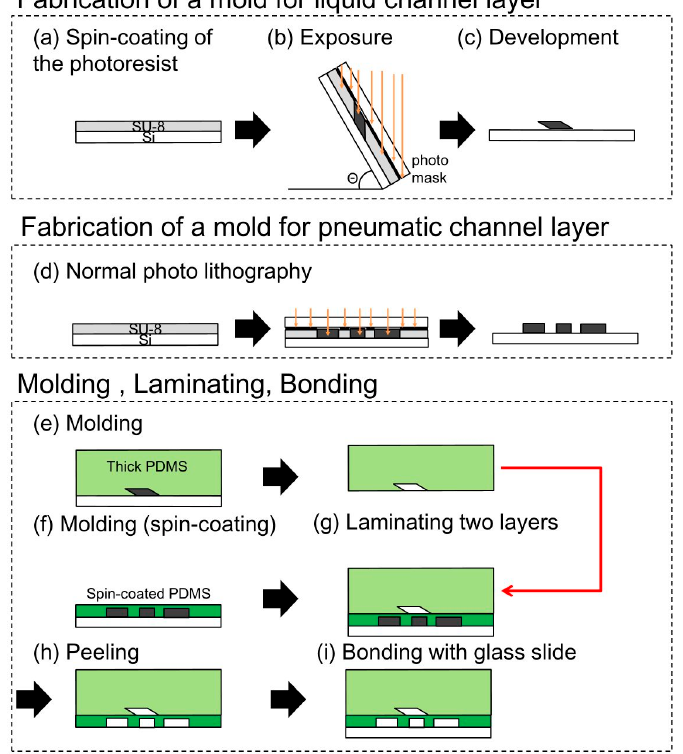
Figure 4. Fabrication process of the proposed pneumatic microvalve for a tall micro channel.